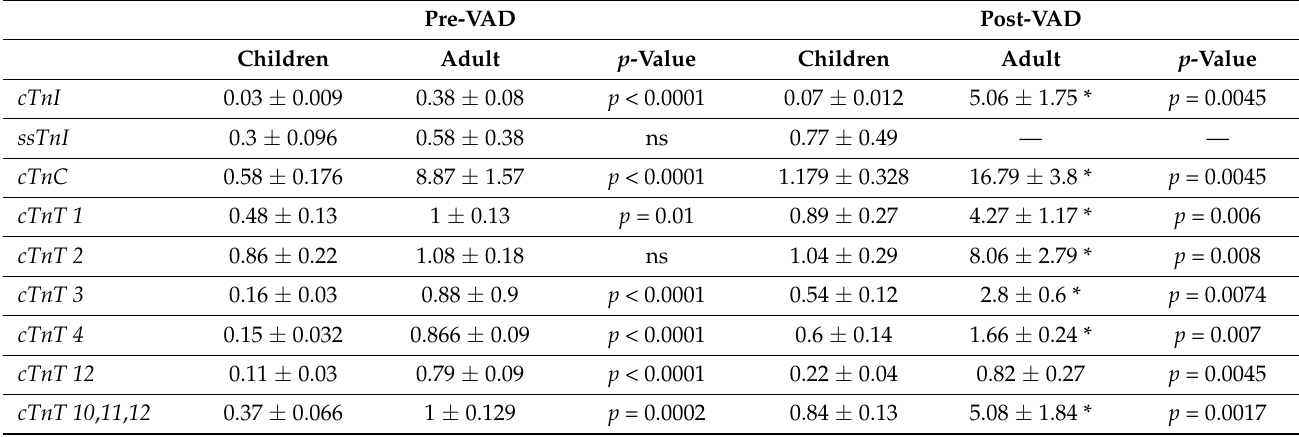
Table 2. Comparison of cardiac troponin complex expression levels among HF children and HF adult patients before (Pre-VAD) and after (Post-VAD) VAD support.